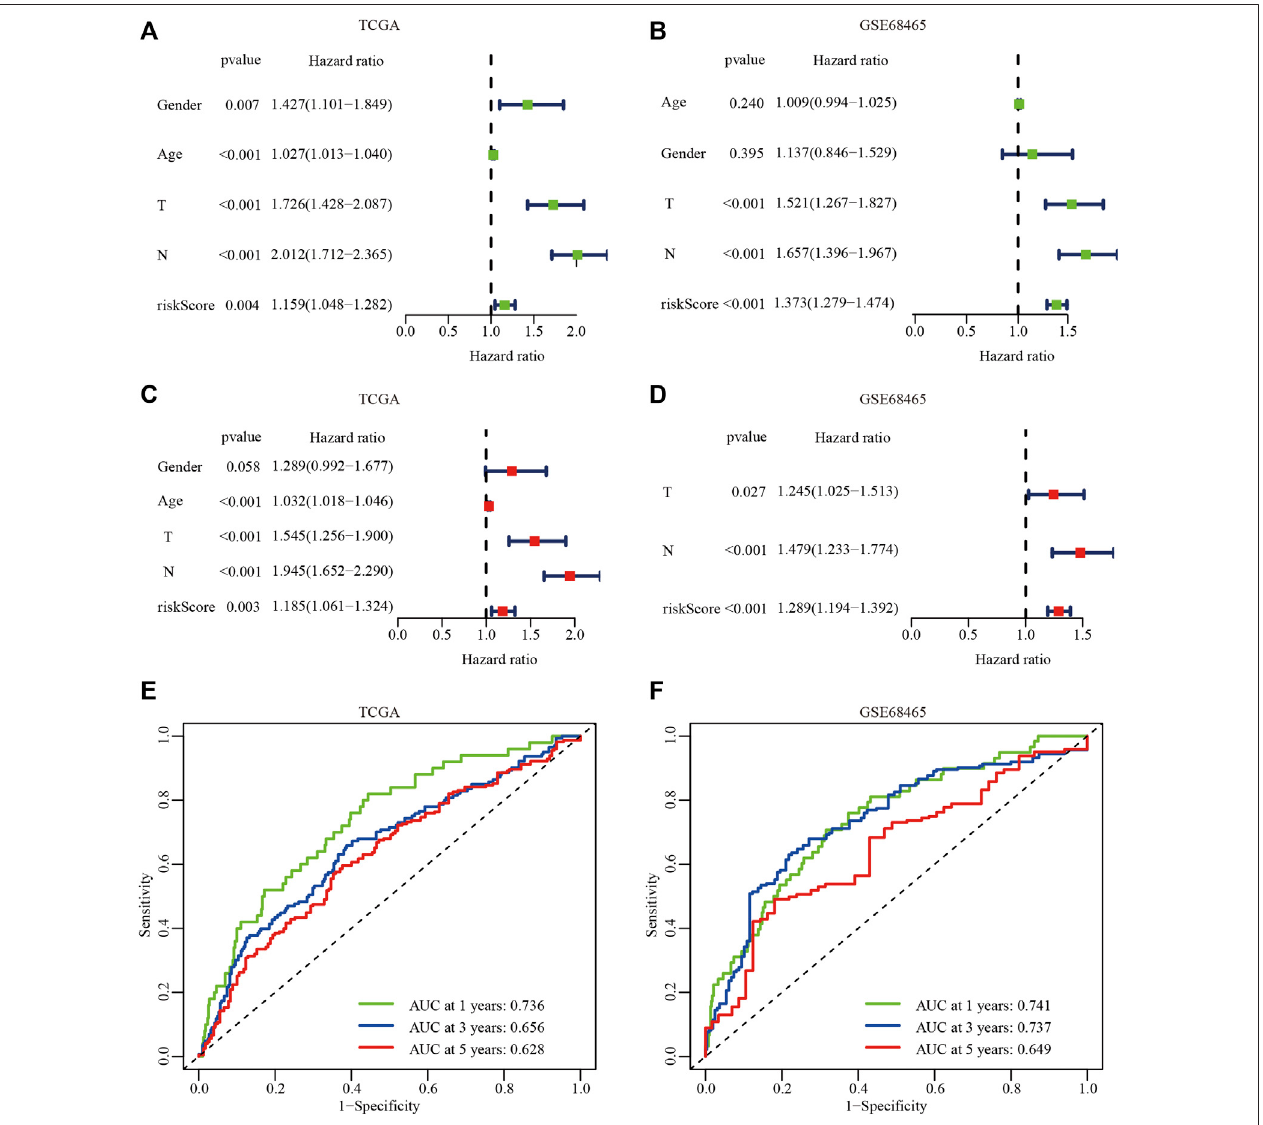
FIGURE 5 | The independent prognostic analysis of the hypoxiarelated risk signature. (A, B) Univariate Cox analysis of clinical characteristics and hypoxiarelated risk signature in the TCGA (A) and GSE68465 dataset (B) . (C, D) Multivariate Cox analysis in the TCGA (C) and GSE68465 dataset (D) . (E, F) AUC of the hypoxia risk signature in the TCGA (E) and GSE68465 datasets (F)